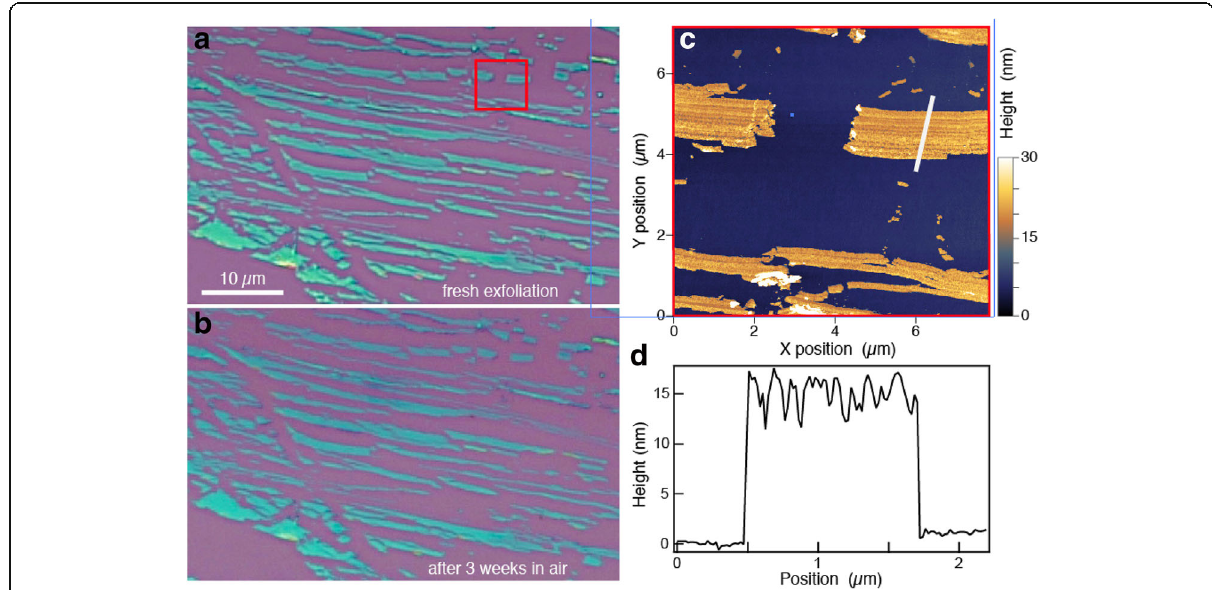
Fig. 2 a Te exfoliated on a Si/SiO2 substrate, imaged immediately after exfoliation. b The same sample as in ( a ) after storage in air for 3 weeks. c AFM height image of the area inside the red square in ( a ). d Height profile along the white line shown in ( c